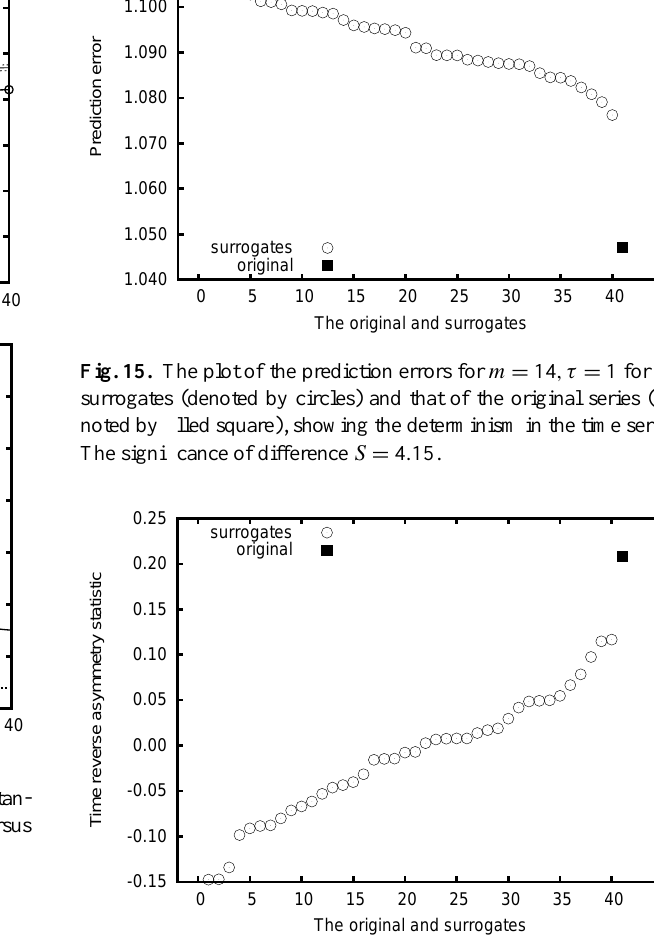
Fig. 16. The plot of the time reversal asymmetry statistic for delay τ = 14 for the surrogates (denoted by circles) and that of the orig- inal series (denoted by filled square), showing the determinism in the time series. The significance of difference S = 2 .